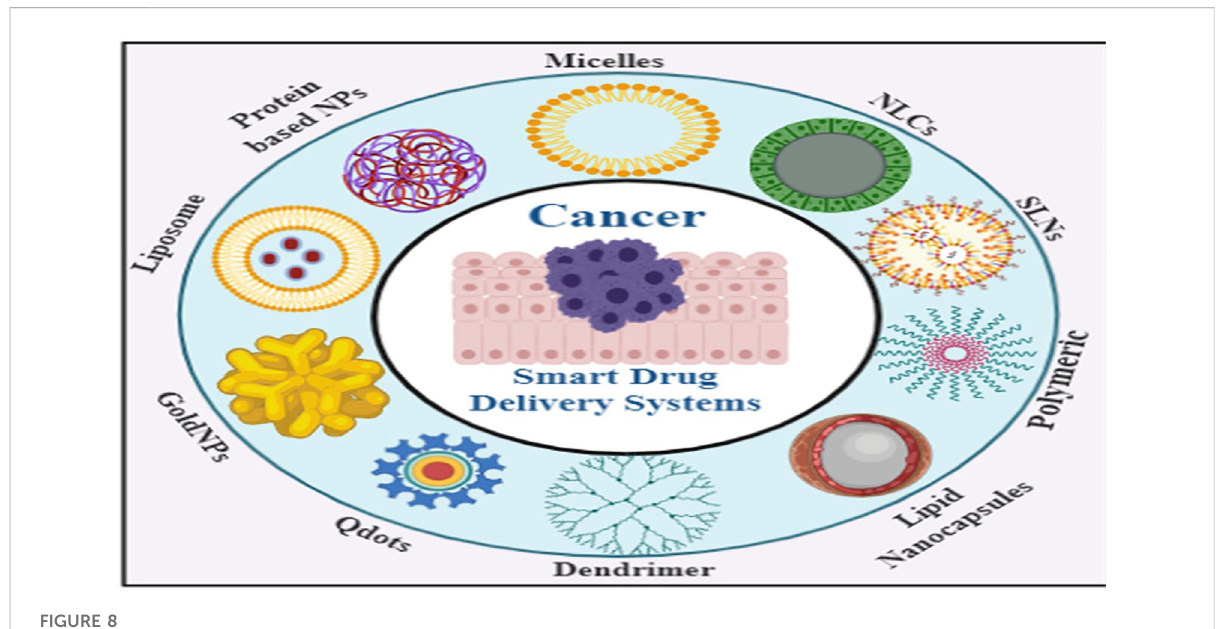
FIGURE 8 Smart nanocarriers used in